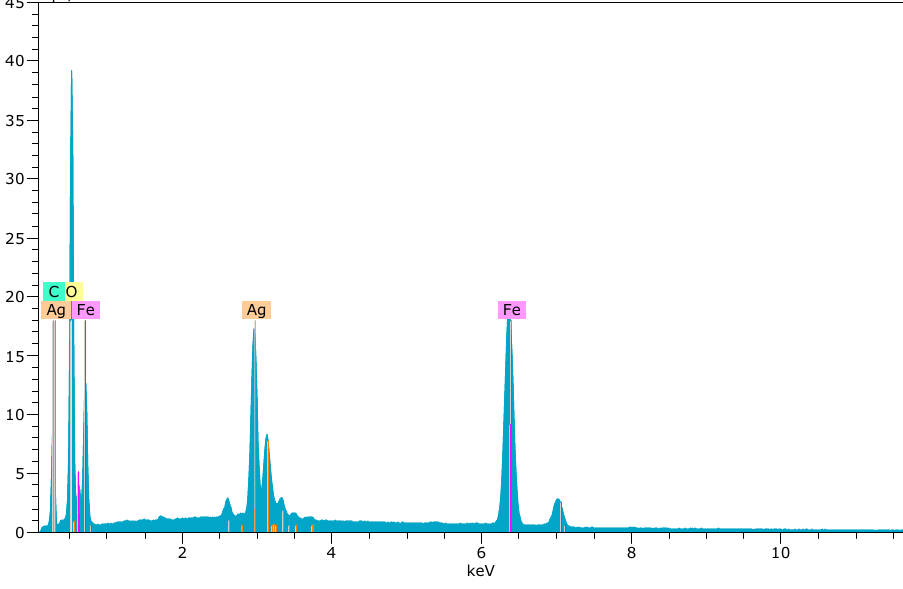
(0.525 keV) are shown in the figure. (0.705 and 6.398 keV), and O